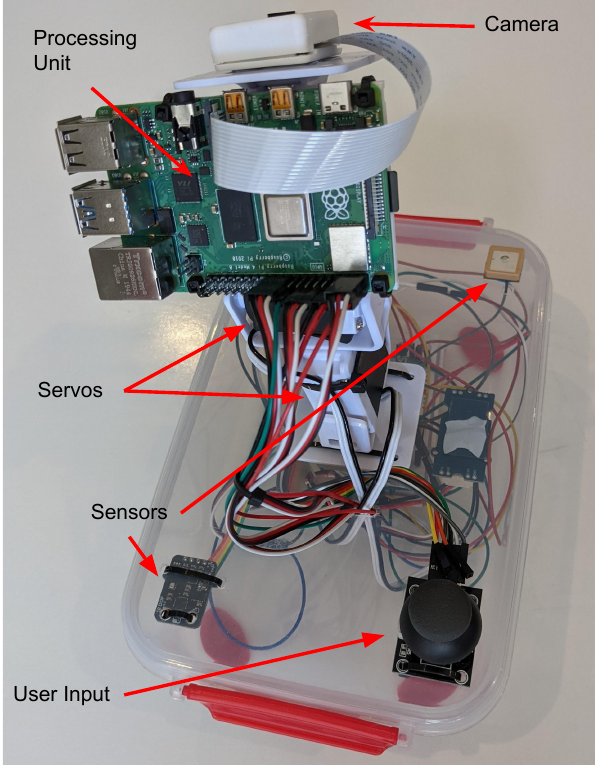
Figure 3. Physical implementation of the proposed ‘TrackInk’ framework with labelled